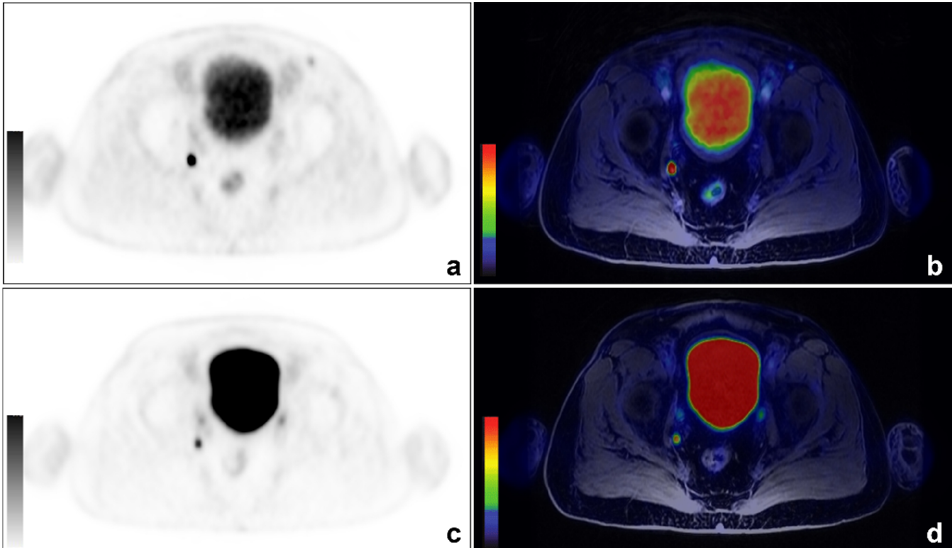
Figure 1. An example of concordant findings between 68 Ga-PSMA and 68 Ga-DOTA-RM2 PET/MRI in detecting PCa lymph nodal recurrence. A 66-year-old patient previously treated with radical prostatectomy for a Gleason 7 (4 + 3) PCa (pT3aN0) experienced biochemical recurrence (PSA: 0.53 ng/mL). 68 Ga-PSMA PET/MRI images showed a focal right obturator lymph nodal uptake (( a ): axial 68 Ga-PSMA PET; ( b ): axial 68 Ga-PSMA PET/MRI). The same finding is visible on 68 Ga-DOTA-RM2 PET/MRI images ( c ): axial 68 Ga-DOTA-RM2 PET; ( d ): axial 68 Ga-DOTA-RM2 PET/MRI) .